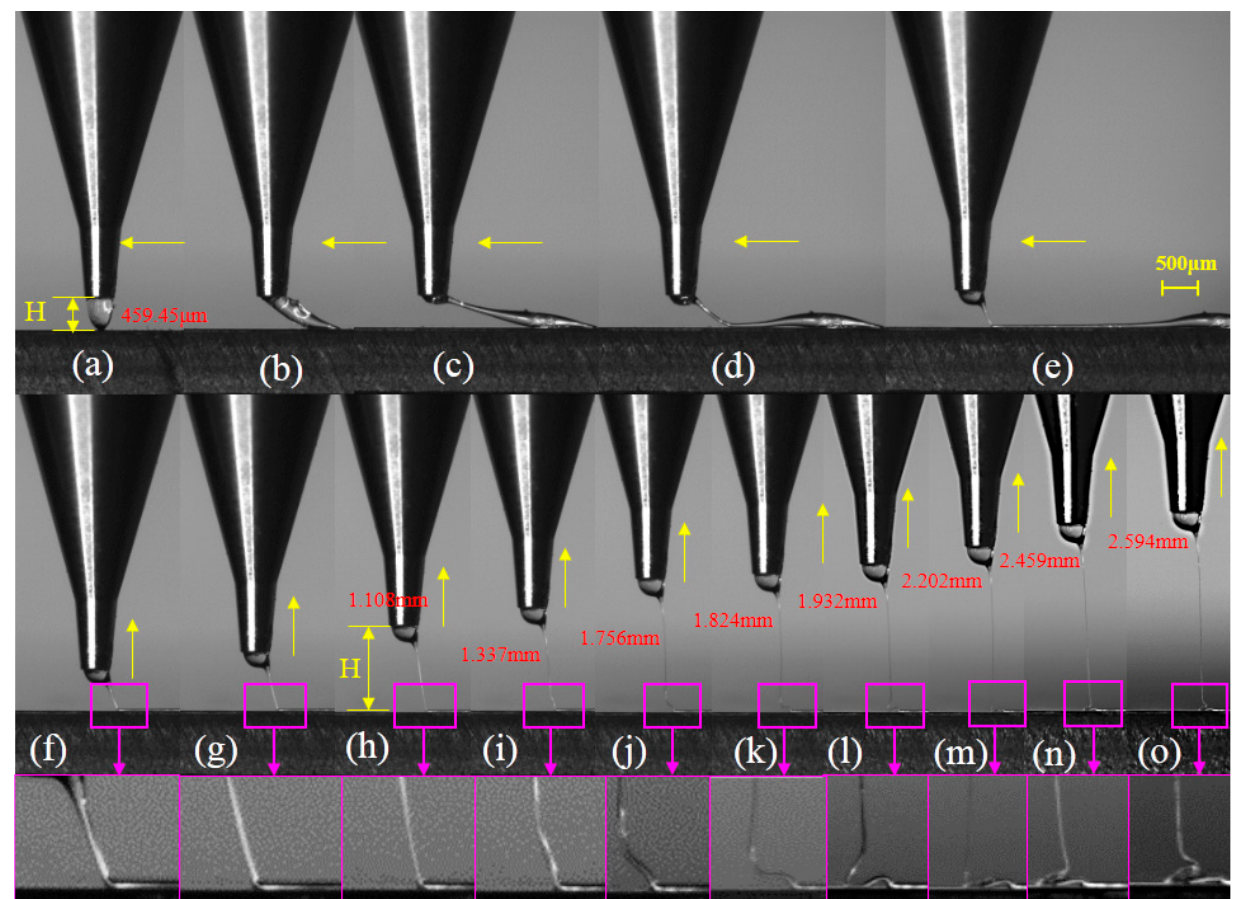
Figure 7. Deposition morphology of jet at different deposition heights. ( a ) The initial value of H was set as 495.45 µ m; ( b – e ) the process of forming fine fibers by the cone-jet stretching; ( f – o ) the nozzle begins to move upward at a uniform